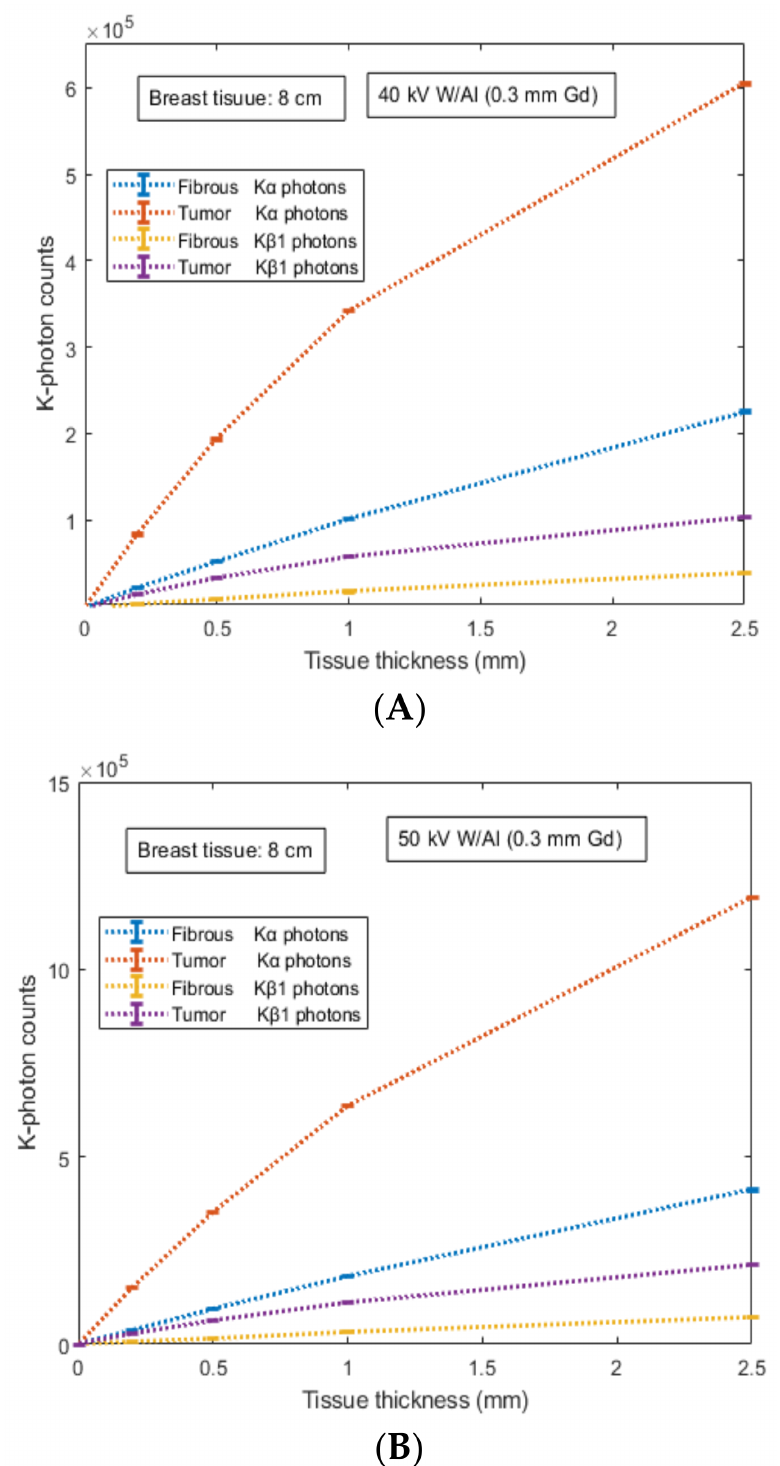
Figure 6. Figure shows the number of K -X-rays ( K α and K β 1 ) counted by the 700 µ m converter layer of Si detector. Results are provided for: (a) two X-ray spectra: ( A ) 40 kV- W/Al (1.6 mm) and ( B ) 50 kV- W/Al (1.6 mm) with additional filtration 0.3 mm Gd; (b) two types of internal tissue (fibrous and tumor) with thicknesses ranging from 0.2 mm up to 2.5 mm; and (c) external fat tissue of 8 cm thickness. Numerical values are expressed by the mean value and their corresponding standard